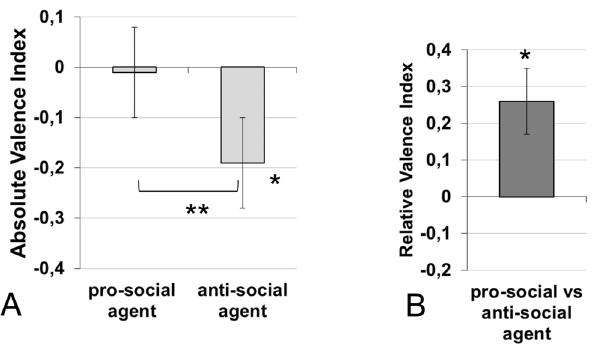
Figure 1. Average indexes for 29 months-olds. A. Average Absolute Valence Index for 29-months-old toddlers computed over the responses to the individual questions regarding the pro-social agent and the anti-social agent separately. *p , .05 (between subjects),**p , .02 (within subjects). A positive score indicates a positive verbal statement toward the agent and vice versa for negative scores. The error bars correspond to one between-subject standard error above and below the mean. B. Average Relative Valence Index computed over the responses to the contrastive questions. A positive score indicates a more positive assessment of pro-social than the anti-social agent, vice- versa for negative scores. The error bars correspond to one between- subject standard error above and below the mean. *p , .05.